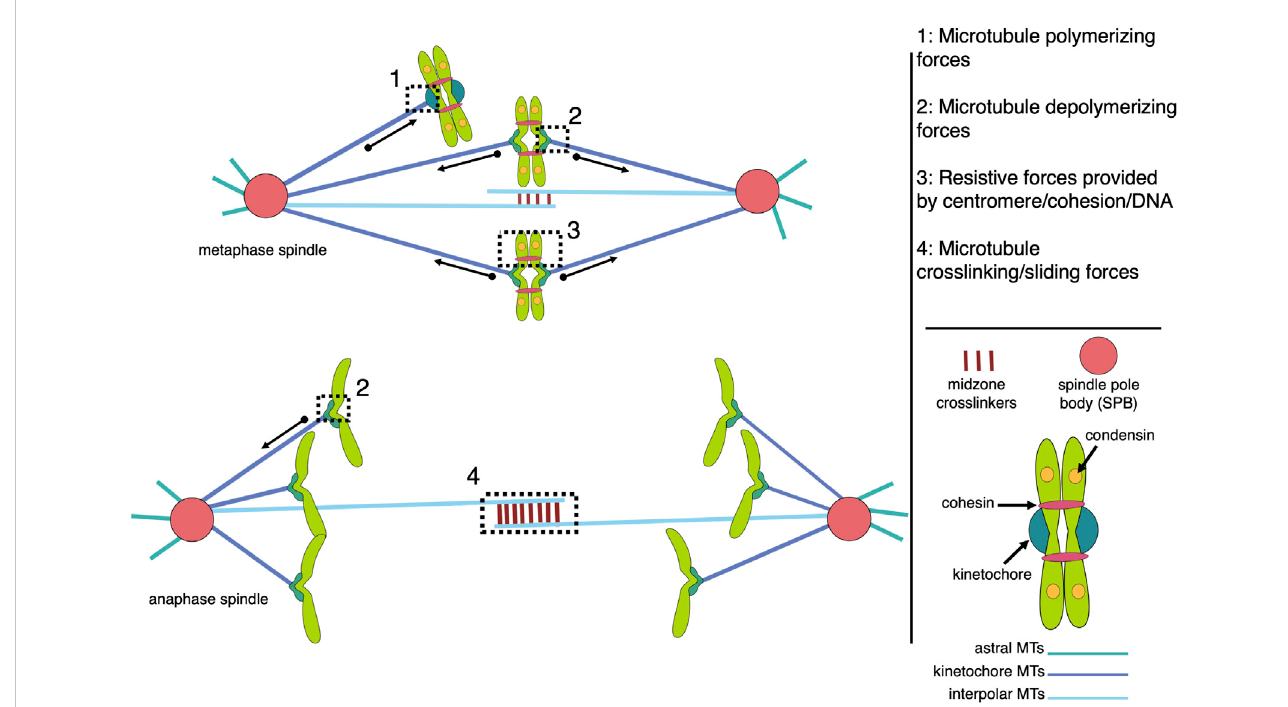
FIGURE 1 Models of microtubule-associated forces in metaphase and anaphase mitotic spindles. The spindle is composed of three major classes of microtubules (interpolar,kinetochore,andastral),eachwithuniquefunctionsthatcontributetotheforcesgeneratedwithinthebipolarstructure.Theforcesofnoteinclude pushing and pulling forces resulting from microtubule polymerization and depolymerization, respectively, which are largely responsible for chromosome movement (1 and 2), and resistive forces, or tension, generated across pairs of sister kinetochores and centromeres, which are coupled by centromere- associated condensin and cohesin protein complexes (3). MAPs (microtubule associated proteins) crosslink antiparallel interpolar microtubules to create a stable midzone that allows kinesin motor proteins to generate sliding forces that push the spindle poles apart (4). While all four types of forces are active in metaphase spindles, tension across sisters is terminated by cohesion cleavage at the metaphase-to-anaphase transition while anaphase chromosome movement is dominated by microtubule-generated pulling